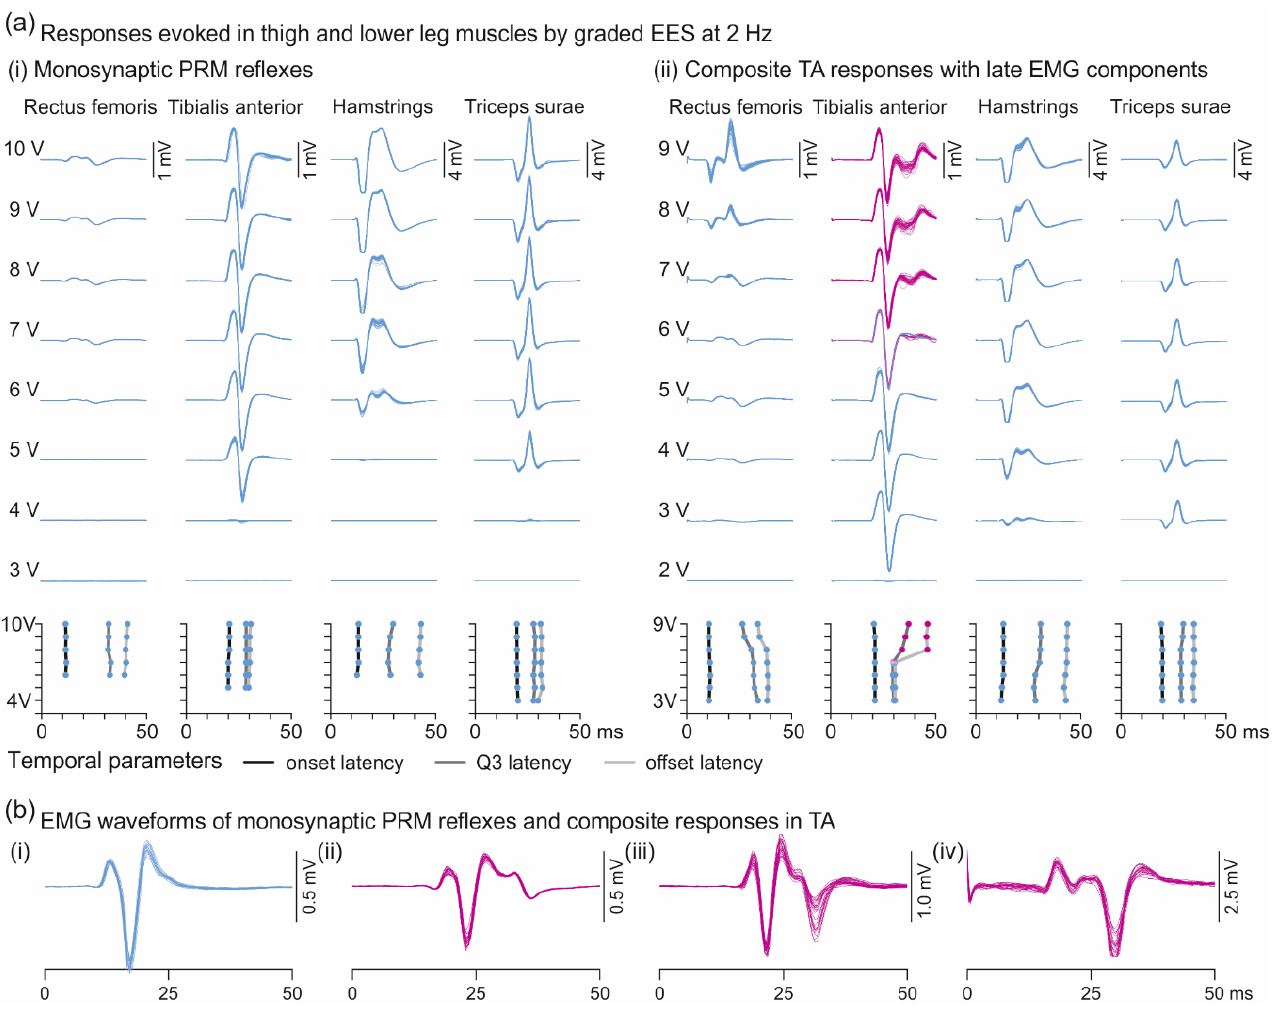
Figure 5. Responses of thigh and lower leg muscles to 2-Hz EES with incremental amplitudes. ( a ) ( i ) Monosynaptic PRM reflexes elicited across EES amplitudes in all four muscle groups studied. ( ii ) A change in electrode setup within the same recording resulted in the elicitation of late EMG components in TA (magenta traces) with EES amplitudes ≥ 2 × response threshold. Graphs below EMG traces illustrate corresponding mean onset and offset latencies as well as Q3 latencies for each EES amplitude. Note the sharp shift of offsets and Q3 latencies with the occurrence of the late EMG components. All examples derived from subject 4, recording 5, ( i ), electrode setup 0+1 − , ( ii ), 1 − c+. ( b ) Examples of EMG waveforms of monosynaptic PRM reflexes in TA ( i , blue traces) and of composite TA responses ( ii – iv , magenta) with increasing contribution of the late EMG components. All examples derived from subject 3, ( i ) electrode setup 0+3 − , 3 V; ( ii ) 0+2 − , 6 V; ( iii ) 0+3 − , 5 V, all recording 2; and ( iv ) 3 − c+, 10 V, recording 1. Twenty to 26 stimulus-triggered EMG traces shown superimposed in each panel. EES, epidural electrical stimulation; PRM, posterior root-muscle; TA, tibialis